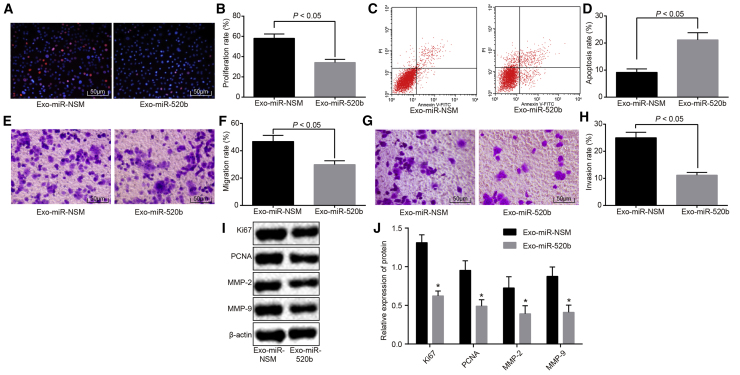
Exosomal miR-520 Overexpression Derived from NFs Inhibits Proliferation, Migration, and Invasion and Promotes Apoptosis of PC Cells(A) Representative images of proliferation of SW1990 cells in a coculture system with exosomes derived from NFs detected by the EdU assay (×200). (B) Proliferation rate of SW1990 cells was suppressed by miR-520b in the exosomes derived from NFs. (C) miR-520b in the exosomes derived from NFs increased SW1990 cell apoptosis revealed by flow cytometry. (D) Apoptosis rate of SW1990 cells was enhanced by miR-520b in exosomes derived from NFs. (E) Representative images of SW1990 cell migration ability in a c-culture system with exosomes derived from NFs demonstrated by the Transwell assay (×200). (F) Migration rate of SW1990 cells was decreased by miR-520b in exosomes derived from NFs. (G) Representative images of SW1990 cell-invasion ability in a coculture system with exosomes derived from NFs revealed by the Transwell assay (×200). (H) Invasion of SW1990 cells was decreased by miR-520b in the exosomes derived from NFs. (I) Protein band diagram of proliferative markers (Ki67, PCNA) and invasive markers(MMP-2, MMP-9) in exosomes derived from NFs detected by Western blot analysis. (J) Expression of proliferative markers (Ki67, PCNA) and invasive markers (MMP-2, MMP-9) in exosomes derived from NFs determined by Western blot analysis.. *p < 0.05 versus the Exo-miR-NSM group. Data in the figure were denoted as measurement data, which were expressed as mean ± standard deviation, and the difference of which between two groups was compared by independent-sample t test. The experiment was repeated 3 times independently.